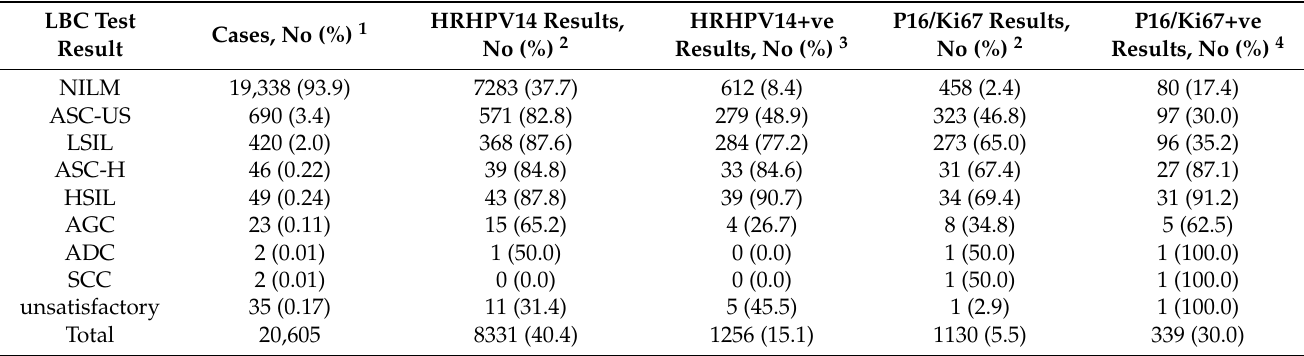
Table 5. Overall NILM, ASC-US, LSIL, ASC-H, HSIL, and AGC reporting rates in the study group with relevant HRHPV14 and p16/Ki67 results.